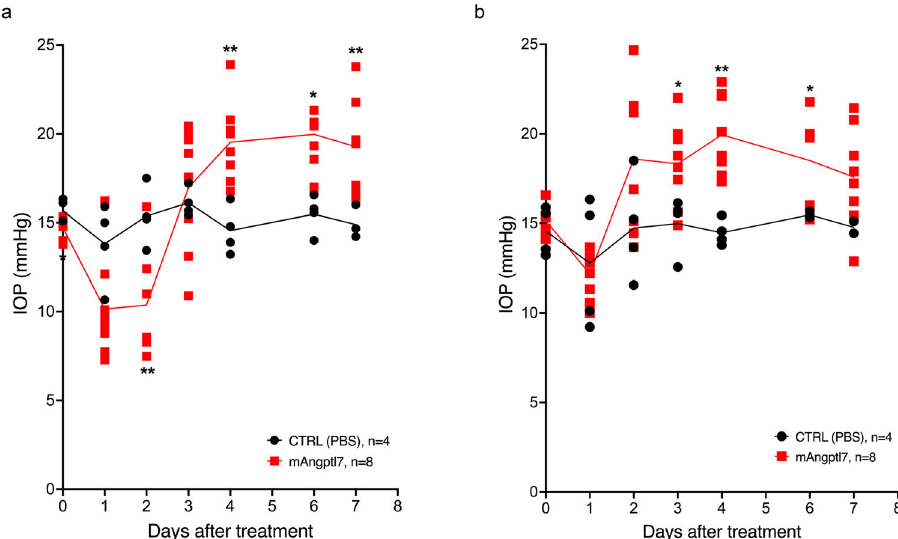
Fig. 6 Increasing mAngptl7 levels in mouse eyes increases IOP. Murine Angptl7 (mAngptl7) protein was injected into mouse eyes via intravitreal ( a ) or intracameral route ( b ), and IOP was measured over time. After an initial drop, IOP remained elevated for several days in mAngptl7-treated eyes compared to PBS treated (CTRL (PBS)) eyes. * = P < 0.05; ** = P < 0.01 statistical signi fi cance compared to PBS treatment. Statistical analyses were performed using Student ’ s t test.